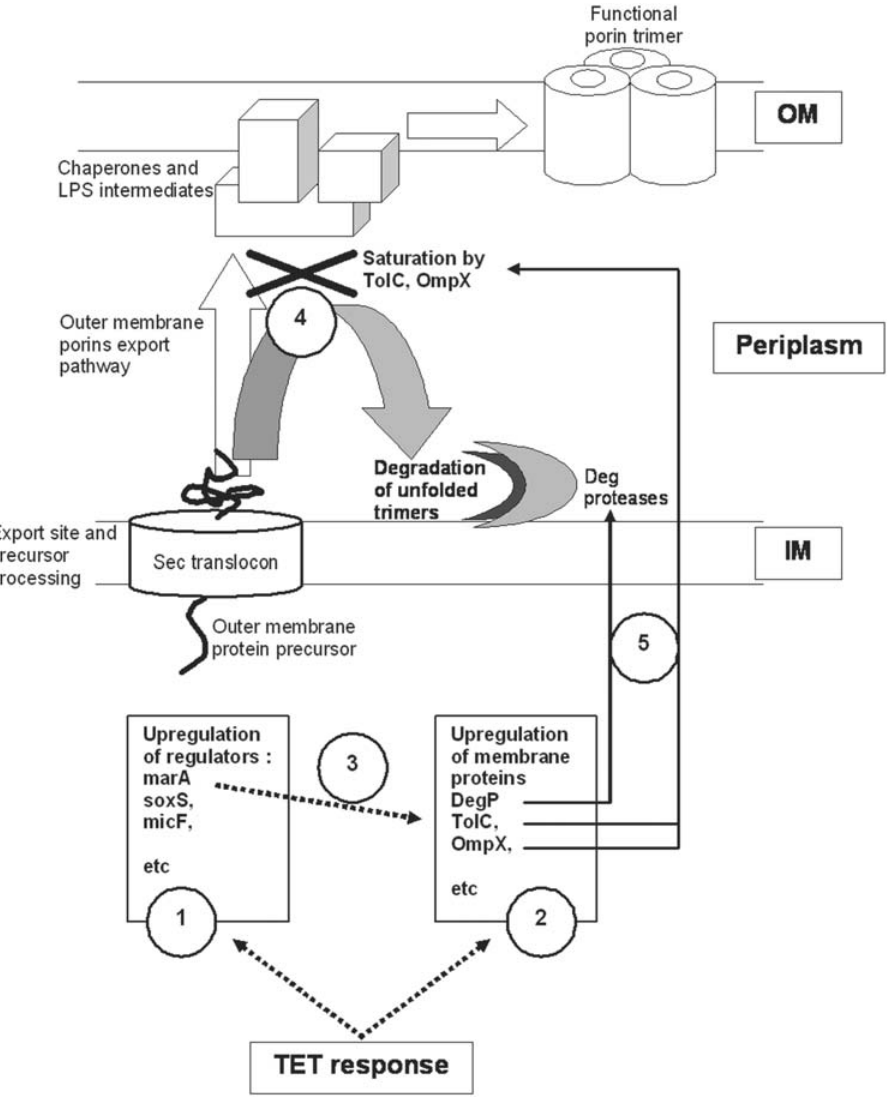
Figure 4. Tetracycline activation cascade of E.coliresistance physiological adaptation. Broken arrows indicate the activation in 1 and 2 over- expression of specific gene (direct TET pressure effect), in 3, the regulation by induced regulators (second level of control), in 4 the effect of activated genes coding for membrane proteins (third level of effect). Thick arrows (5) illustrate the effect of over-production of OMPs and proteases.